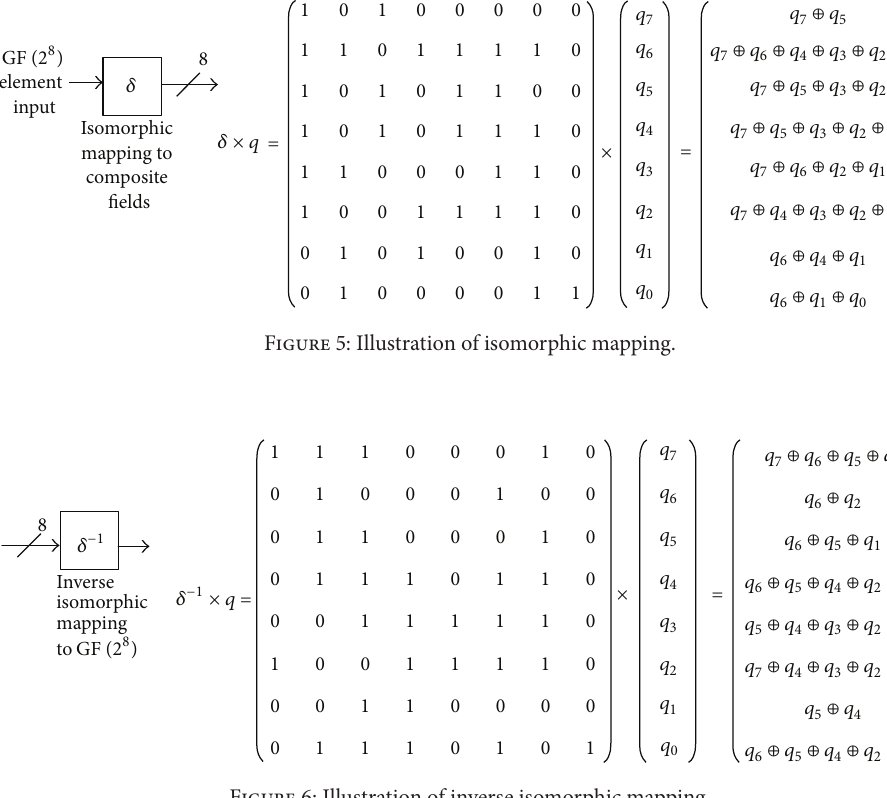
Figure 6: Illustration of inverse isomorphic